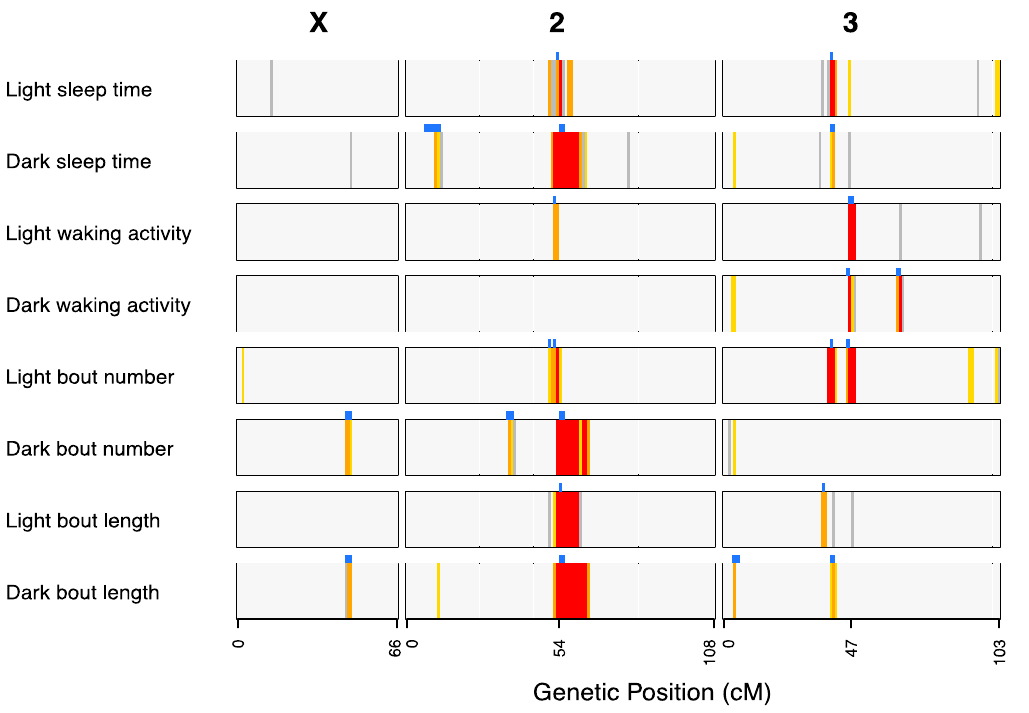
Figure 4. Locations of QTL mapped for all sleep and activity traits in the DSPRF1. The genomewide LOD scores for each trait are depicted as colored vertical stripes within each bar, with colors indicating whether the score survives a trait-specific permutation-based critical threshold (1% = red, 5% = orange, 10% = yellow, 20% = gray; Supplementary Table S5). The blue blocks above each phenotype bar highlight the 3-LOD drop intervals of mapped QTL that survive a 5% threshold.